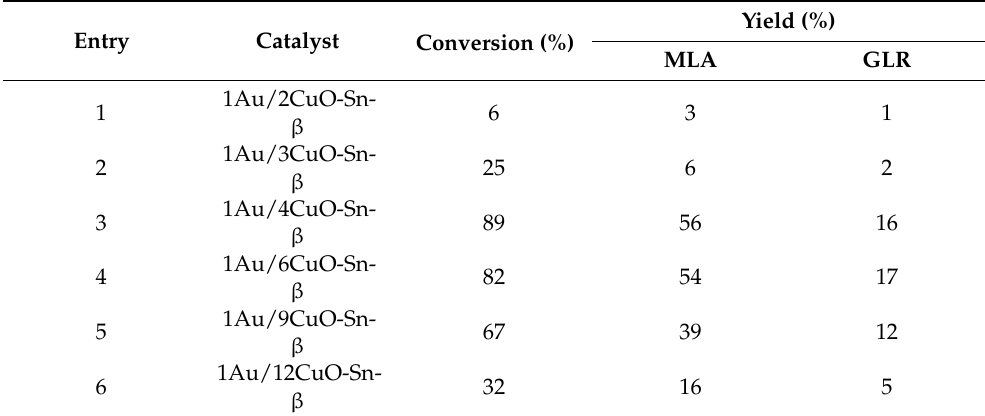
Table 1. Effect of different CuO content on GLY oxide.